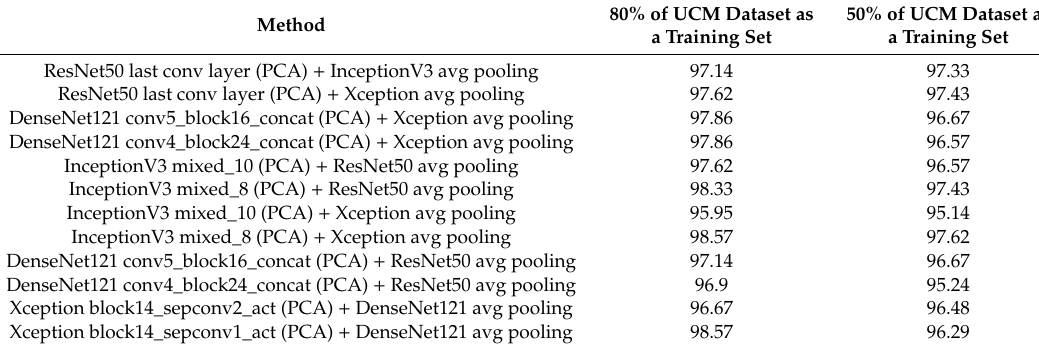
Table 3. The classification accuracy (OA (%)) of the linear classification of fused features with Principal Component Analysis (PCA) transformation, with 80% and 50% of UC-Merced dataset as a training